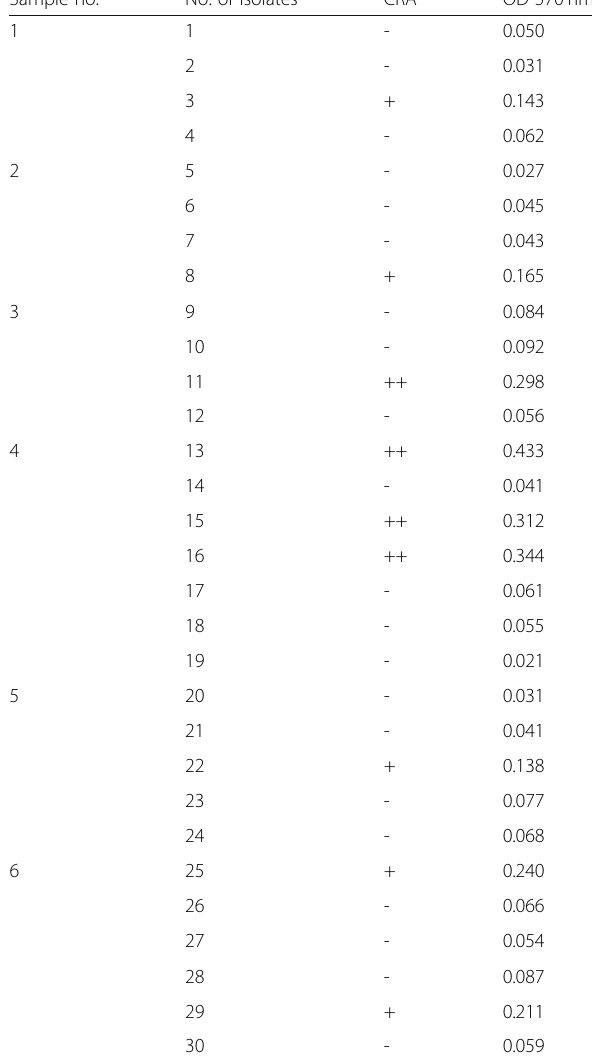
Table 1 Qualitative and quantitative determination of the biofilm formation by Bacillus isolates Sample no.